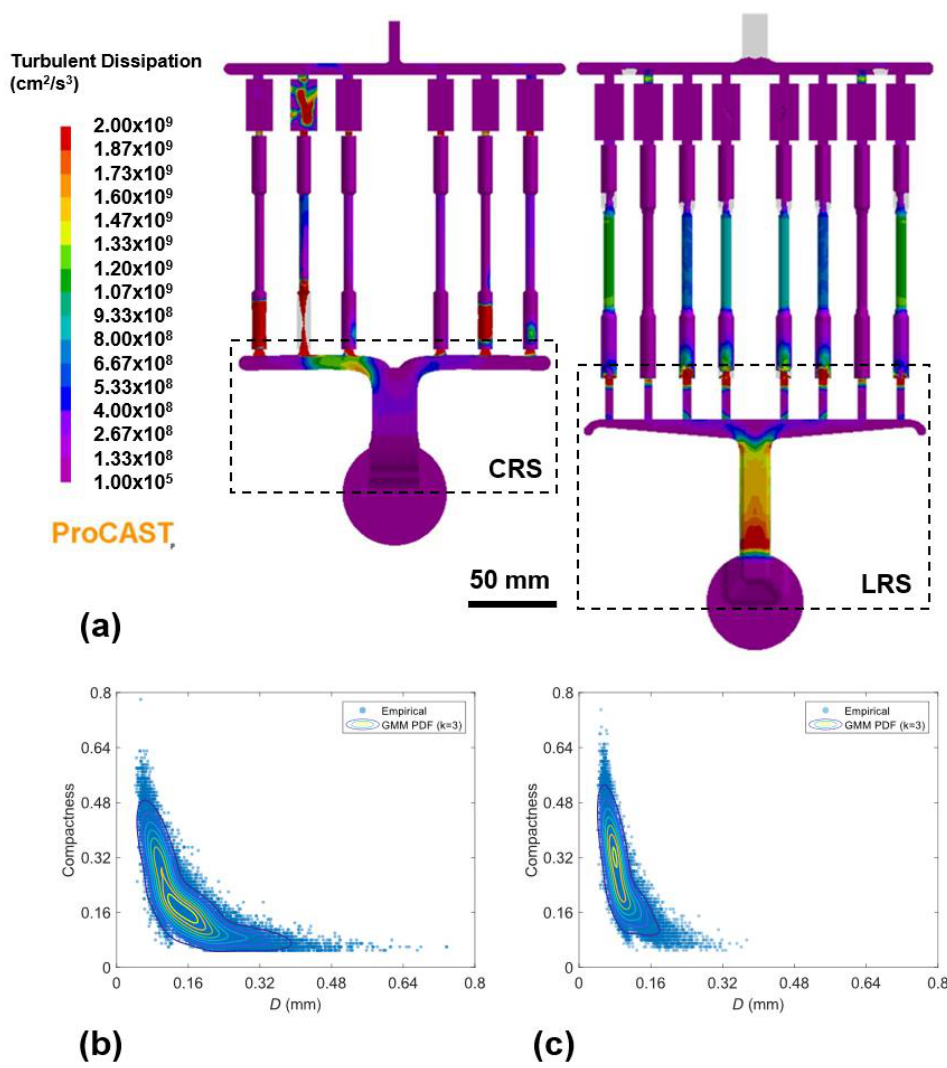
Figure 4. ( a ) ProCAST simulations depicting the dissipation rate of turbulent kinetic energy along the flow path of the CRS and LRS dies. Shown in ( b , c ) are plots of compactness vs. size for inclusion identified in samples produced using the CRS and LRS dies, respectively. A Gaussian mixture model (GMM) was used to model each dataset, with probability density (PDF) contours superimposed on the plots in ( b , c ). The insets (i,ii) show a three-dimensional visualisation of inclusions in each sample [32].